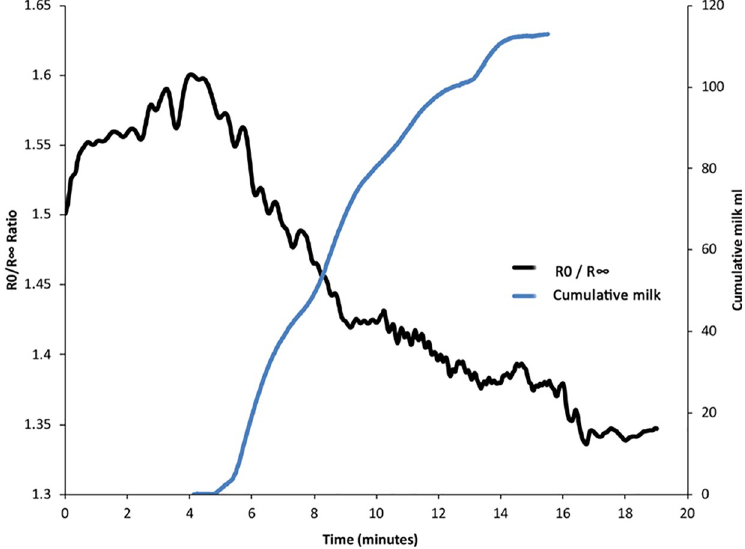
Fig 3. The inverse relationship between the R0 /R 1 ratio and cumulative milk removed for a typical pumping session.